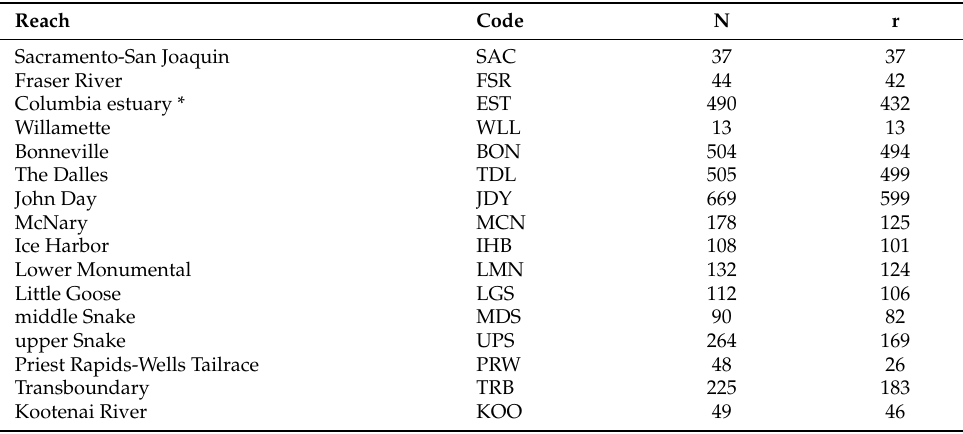
Figure 1. Reaches from which white sturgeon were collected for this study. Diamonds represent hydroelectric dams or water falls delineating reaches inhabited by white sturgeon analyzed in this study (labeled). Lines indicated reaches from which fish were pooled for group-wise analysis. Labels follow Table 1. Table 1. Sample sizes of white sturgeon for each reach, before (N) and after (r) filtering first-degree relatives within each reach. * Columbia River below Bonneville Dam.